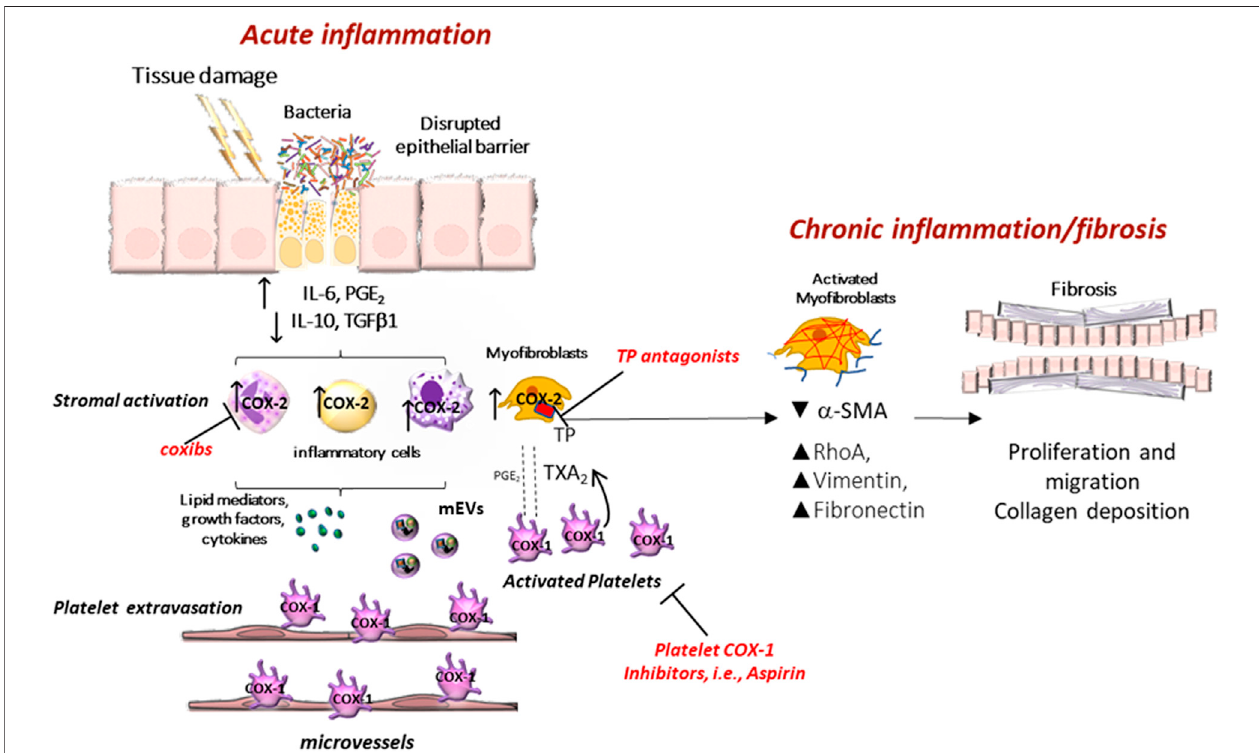
FIGURE2| Clinicalimplications ofeicosanoidinhibitioninintestinaltumorigenesis.Activatedplateletsreleasesolublemediators, includingthromboxaneA 2 (TXA 2 ), prostaglandin E 2 (PGE 2 ), 12S-hydroxyeicosatetraenoic acid (12S-HETE), growth factors, cytokines, and platelet-derived medium-sized extracellular vesicles (mEVs) containing microRNAs, which contribute to the phenotypic changes of the cells in the stromal microenvironment. Interactions between epithelial cells and stromal cells undergoanalteration thatinducesthedevelopmentofintestinalneoplasia.AcrucialeventistheenhancedbiosynthesisofPGE 2 intheintestinalmucosa, occurring in the early stages of tumor development via the cyclooxygenase (COX)-1 activity, in association with the suppression of the prostaglandin-degrading enzyme 15- prostaglandin dehydrogenase (15-PGDH). Later, the overexpression of COX-2 contributes to the generation of aberrant levels of PGE 2 in the stromal compartment and epithelial cells. PGE 2 plays multifaceted roles in cancer promotion, including proliferation, migration, epithelial-mesenchymal transition (EMT), and immune escape. Tumor cells that undergo this phenomenon acquire a migratory capacity that facilitates metastatic colonization. By inhibiting platelet activation, antiplatelet agents can indirectly restrain the induction of COX-2 in target cells. Differently, selective COX-2 inhibitors (coxibs) affect COX-2 activity already expressed in the tumor microenvironment and cancer cells. 12S-HETE generated by 12-lipoxygenase (LOX) may have protumorigenic effects, and selective 12-LOX inhibitors are in clinical